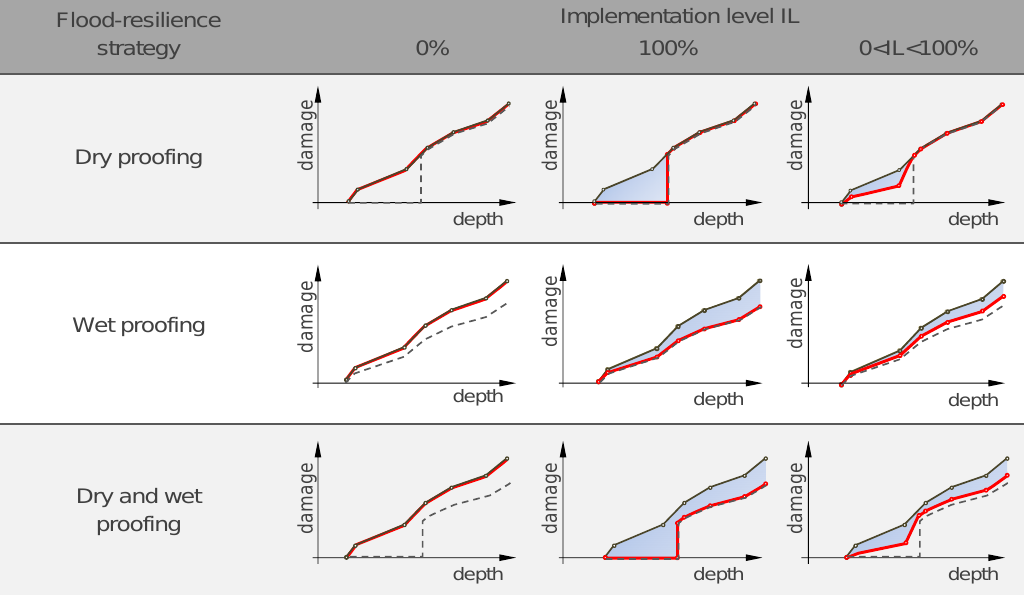
Figure 3. Qualitative effects of the implementation level (IL) as damage dominating attributes depending on selected flood-resilience strategies. Continuous red line: weighted function result; Continuous grey line: implementation level 0%; Dashed grey line: implementation level 100%; Light-blue area: reduced damage as the effect of flood-resilience